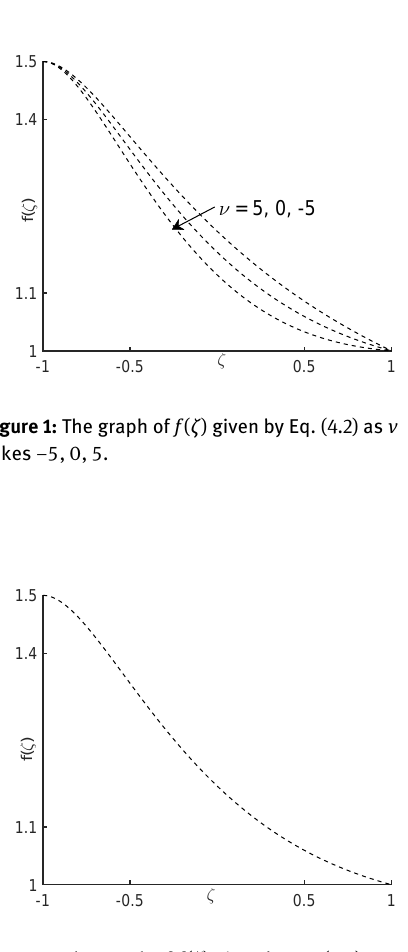
Figure 3: The graph of f ( ζ ) given by Eq. (4.6) . Figure 4: The graph of f ( ζ ) given by Eq. (4.8) for µ = −10, −5, 5, 10